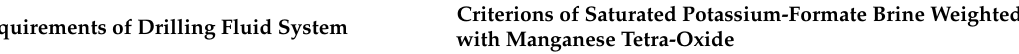
Table 7. Requirement of drilling fluid and weighting agent vs. criterion provided by saturated potassium-formate brine weighted with manganese tetra-oxide.